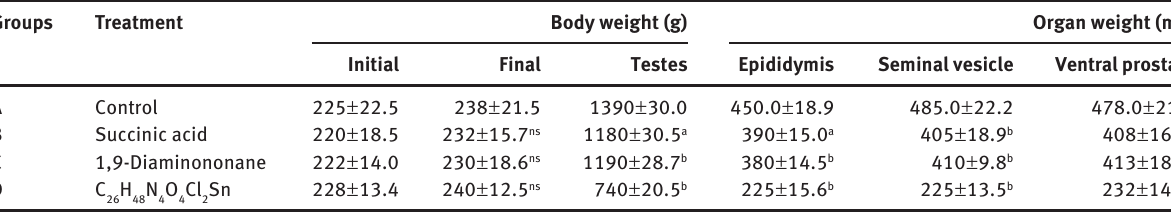
Data are mean ± SEM of five animals.